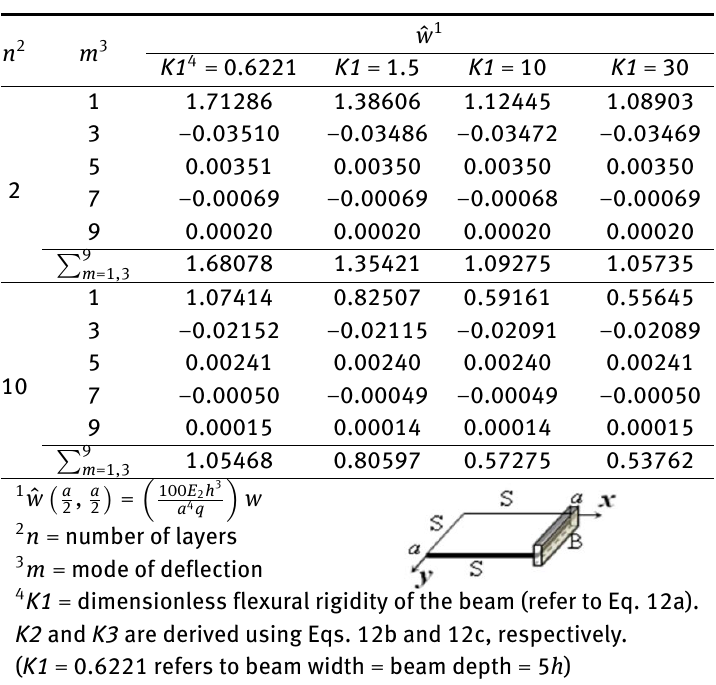
Table 3: ASM convergence study for the center deflection, ^ w ( a /2, a /2) 1 of an antisymmetric angle-ply square plate (30 ∘ /-30 ∘ /30 ∘ /- 30 ∘ / . . . ) having three edges simply supported and the fourth edge ( x = a ) having a beam support of different non-dimensional stiffness K1